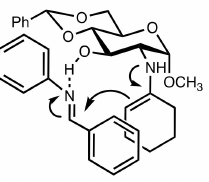
Figure 34. The proposed transition state of the Mannich reaction leading to the syn adduct. The D -glucosamine hydrochloride ( 294 ), the benzylidene derivatives 497 and 498 (see Scheme 128), as well as the benzyl glycosides 508–510 (Scheme 131) were used by Chen and co-workers [197] to catalyse the aldol reaction between several isatin derivatives 511 and acetone (Scheme 132). The organocatalysts 508 and 509 were prepared [198] as